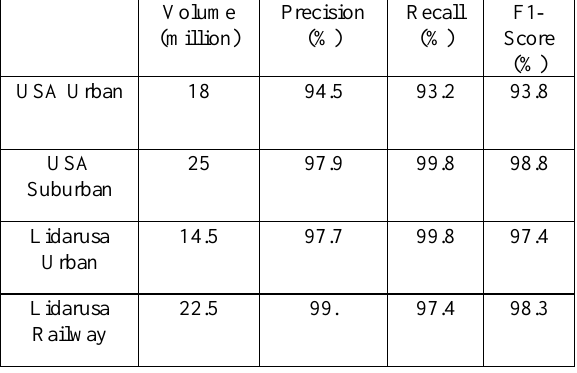
Table 1. The acquired accuracies of proposed algorithm.